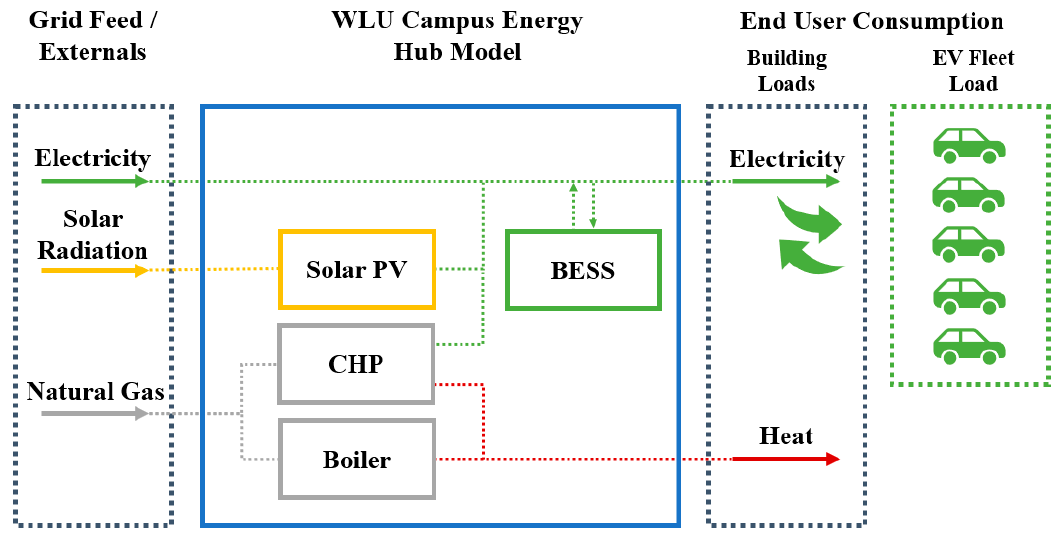
Figure 2 . Holistic representation of energy hub model. CHP—combined heat and power. Figure 2. Holistic representation of energy hub model. CHP—combined heat and